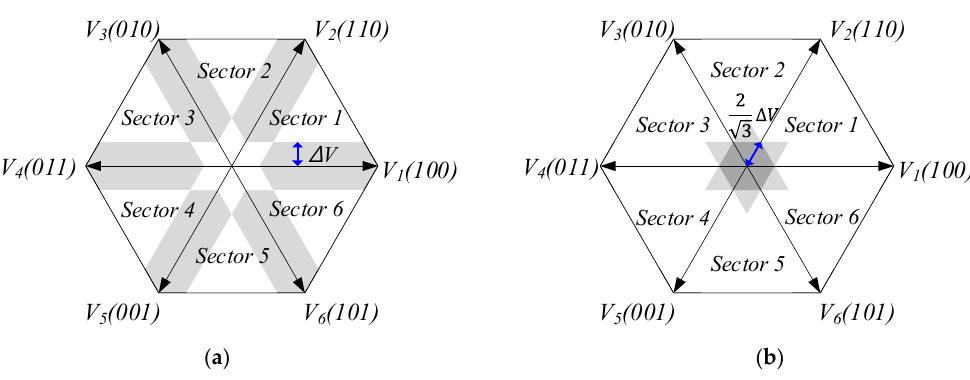
Figure 2. Unmeasurable area in the hexagon of the space vector: ( a ) Bar area; ( b ) Star area.